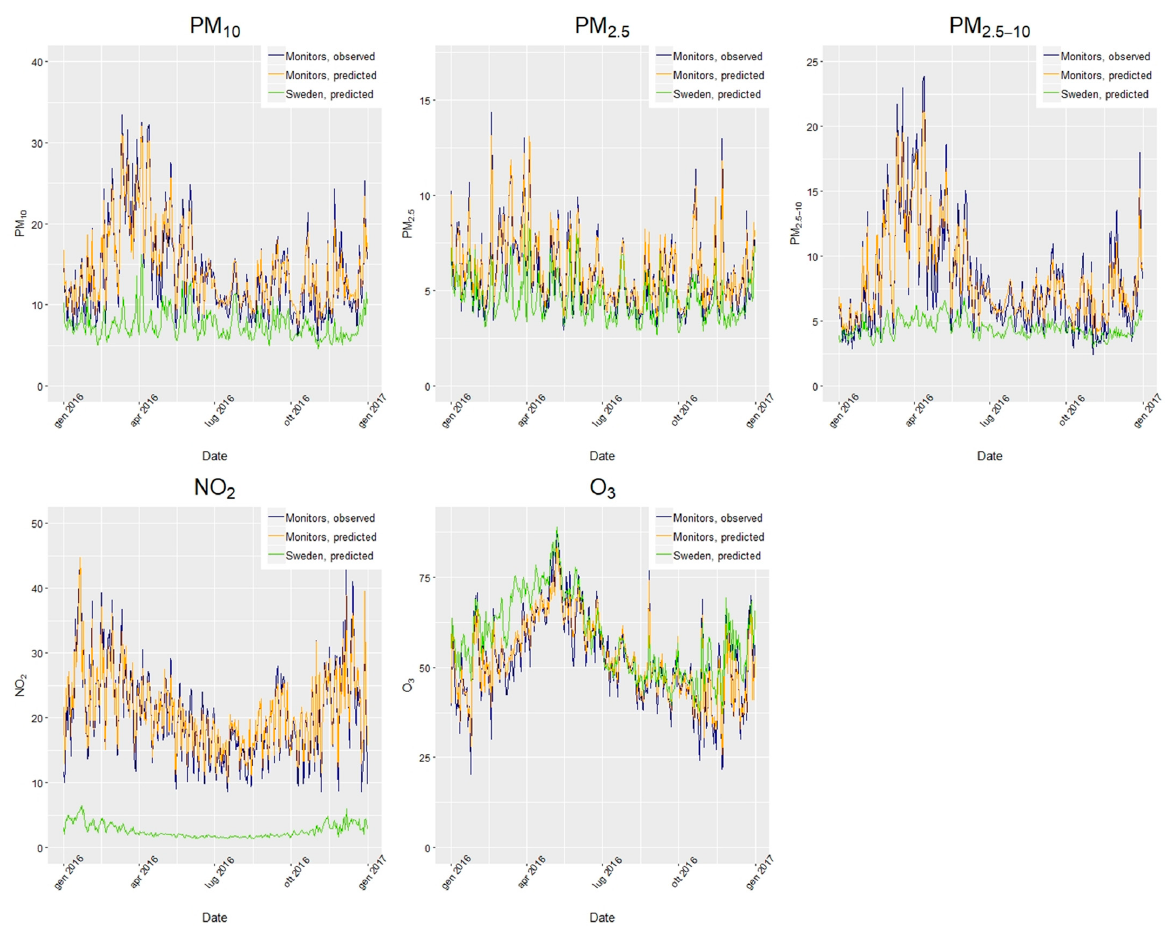
Figure 4. Time series of air pollutant concentrations: daily mean observations (blue line), daily mean predictions at the monitors (orange line), and daily mean predictions for the whole of Sweden (green line), year 2016.